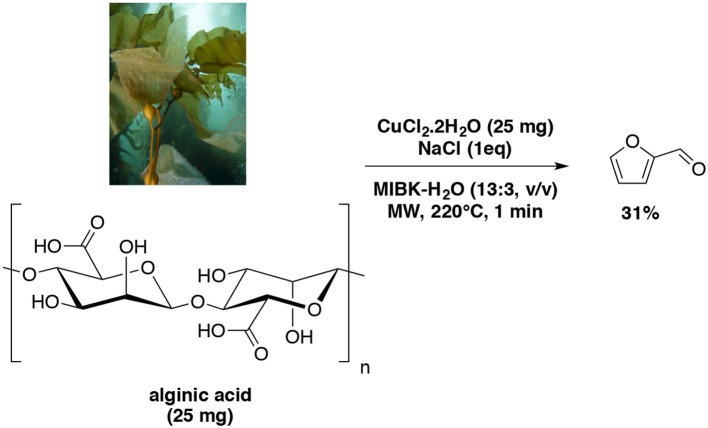
Microwave-assisted production of furfural from D-xylose in the presence of CuCl2.2H2O in a mixture of H2O-MIBK (Wang et al., 2018).